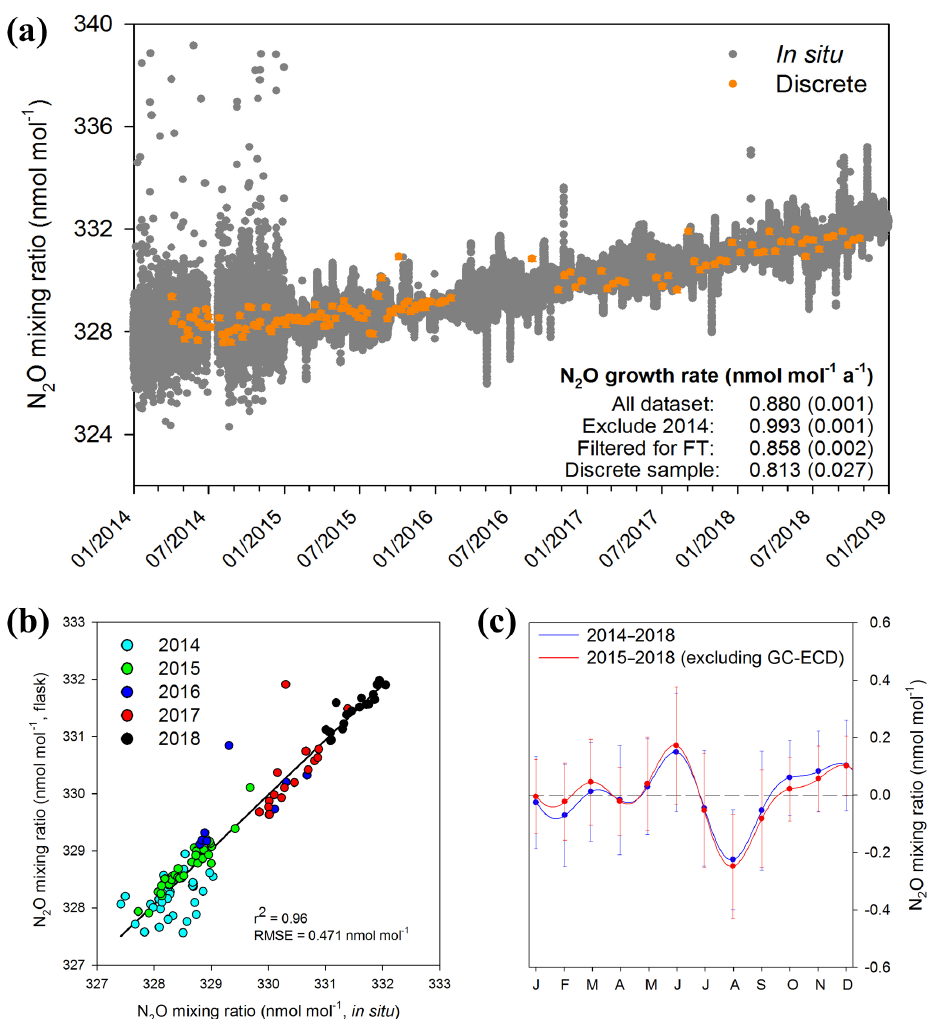
Figure 1. (a) In situ (10min averages) and discrete measurements of N 2 O mixing ratios from April 2014 to December 2018 at Jungfraujoch. In situ N 2 O mixing ratio measurements were performed with the GC-ECD method between April and December 2014. After that, OA-ICOS became the major analytical method for in situ measurements. Discrete sample points are presented as averages with error bars (1 standard deviation). Annual N 2 O growth rates determined by linear regression are given in the figure (uncertainty shown as 1 standard deviation). A sampling gap exists for discrete samples between February and August 2016. (b) Comparison of in situ and discrete measurements of N 2 O mixing ratios; in situ measurements were 10min values averaged over the exact period of discrete sampling time ( ∼ 40min); in situ measurements were performed with the GC-ECD method in 2014, and this was replaced with the OA-ICOS method from January 2015. (c) Seasonality of N 2 O mixing ratios at Jungfraujoch derived from in situ measurements. Datasets with and without GC-ECD measurements are compared for seasonality evaluation. The NLS model simulation for time series gives the detrended seasonality, with error bars indicating 1 standard deviation of monthly